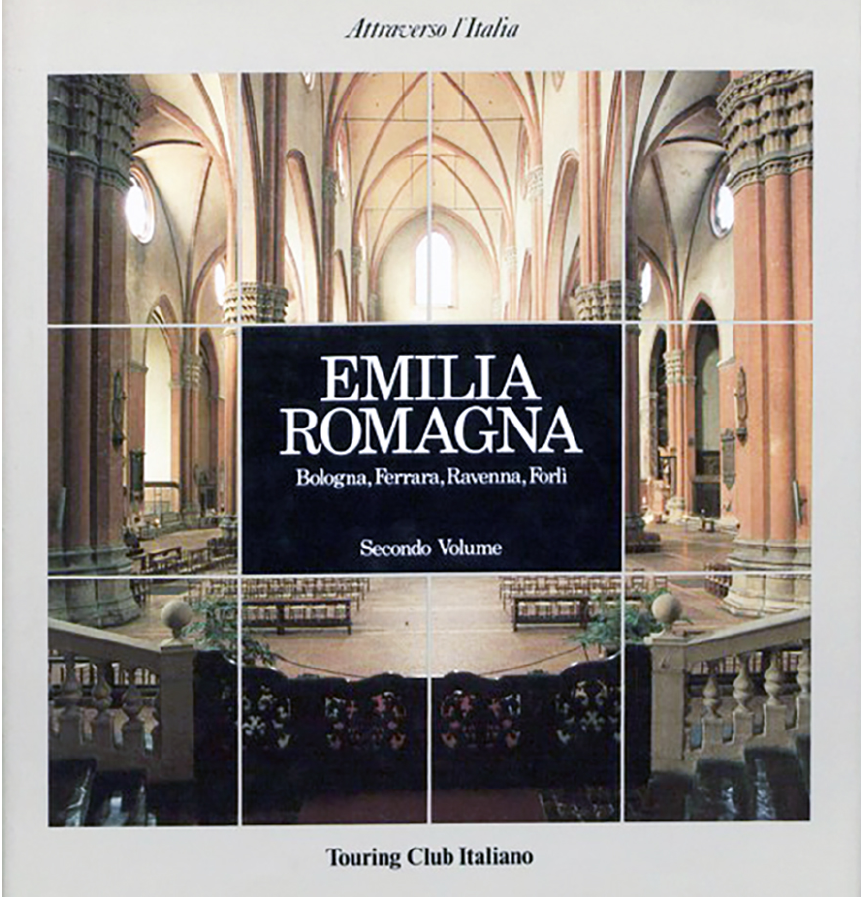
Fig. 3 The cover of Attraverso l’Italia. Emilia Romagna, vol. 2, part of the 21 volumes collection about Italian regions, published by the T.C.I. between 1980 and